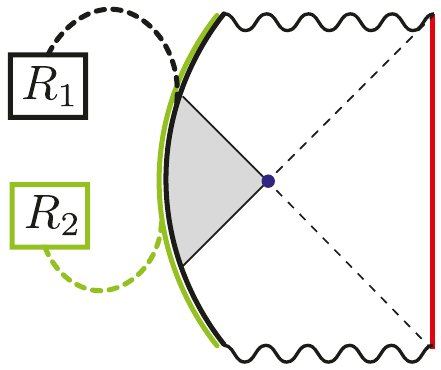
Figure 1 . The Lorentzian description of the state we consider in the West Coast Model, a JT gravity black hole with an ETW brane. The ETW brane carries two sub-flavours, denoted black and green, that are entangled (dashed, coloured lines) with radiation systems R 1 and R 2 respectively. The extremal surface is denoted in purple and the island that dominates after the Page time is coloured